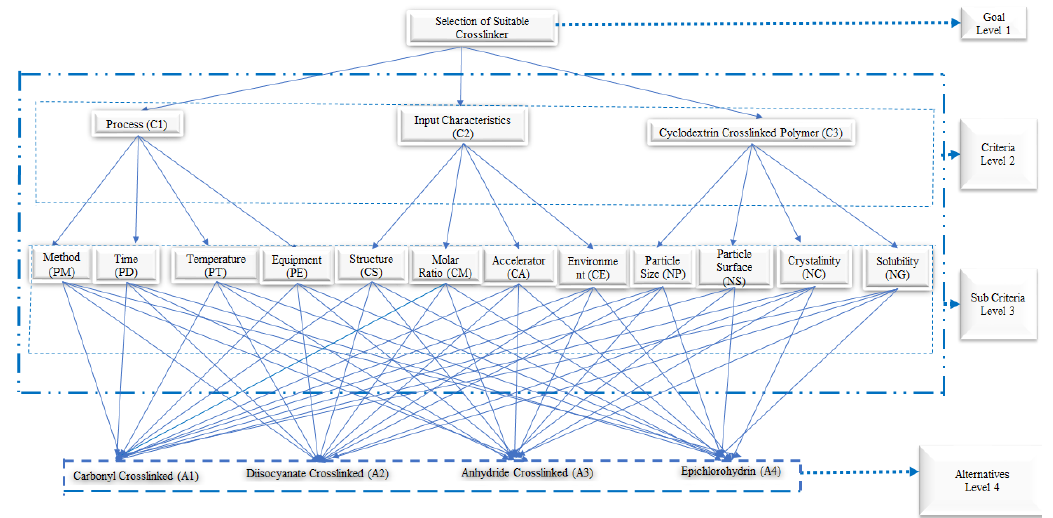
Figure 3. Hierarchy analysis approach to choose the best cross-linker.